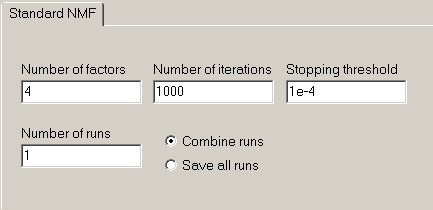
Standard NMF module. This functional module implements the classical NMF algorithm. Different random runs can be executed and results can be either combined in a single output file or saved independently. The application selects the best run based on the minimum error of the model.